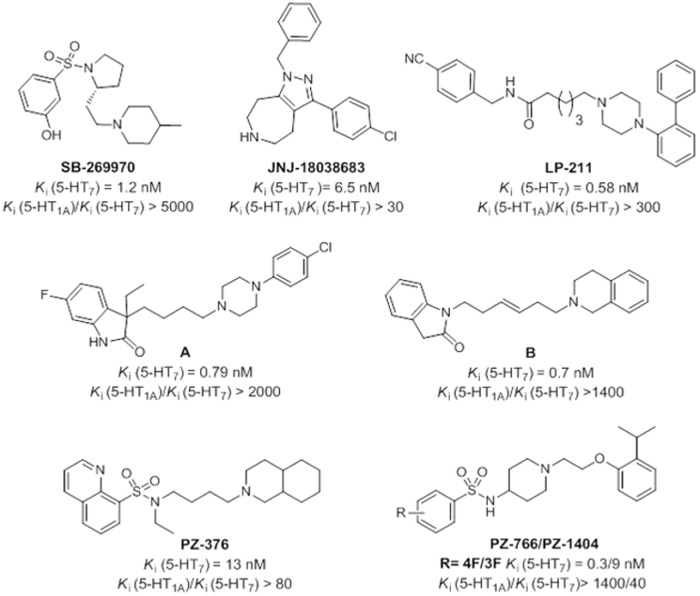
Chemical structure of different chemical classes of selective 5-HT7R ligands [30–37].